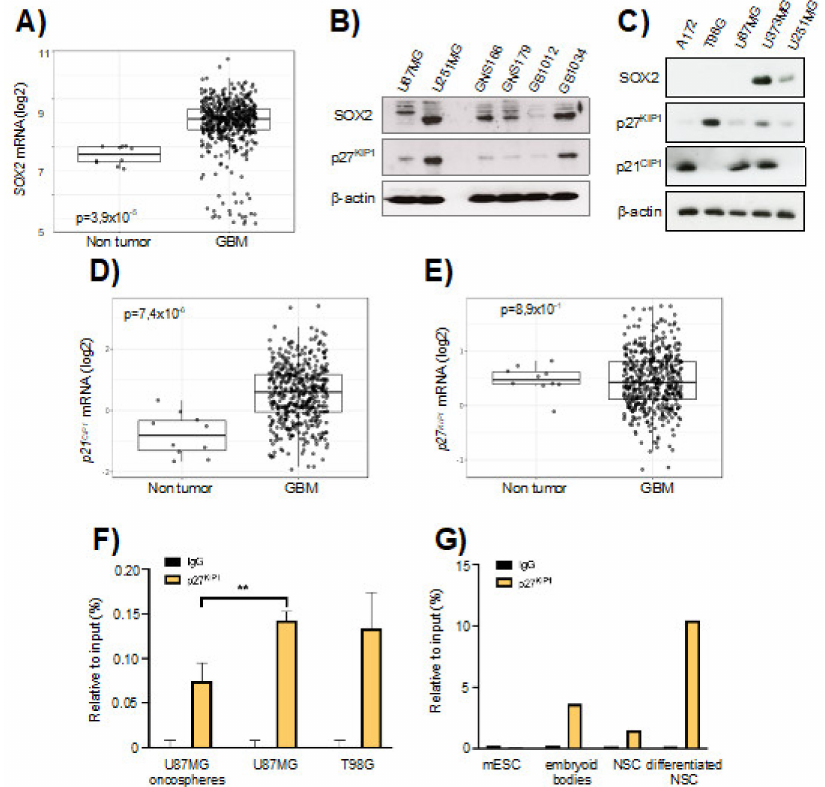
Figure 1. SOX2-SRR2 in glioma cells. ( A ) SOX2 mRNA expression in control ( n = 10) and GBM samples ( n = 528) from The Cancer Genome Atlas (TCGA) cohort in GlioVis database (http://gliovis.bioinfo.cnio.es (accessed on 22 January 2021)). ( B ) Immunoblotting of SOX2 and p27 KIP1 in U87MG and U251MG cell lines, in GNS166 and GNS179 patient- derived stem cell lines and in GB1012 and GB1034 GBM biopsies, β -actin was used as loading control. ( C ) Immunoblotting of SOX2, p27 KIP1 and p21 CIP1 in A172, T98G, U87MG, U373MG and U251MG cells, β -actin was used as loading control. ( D ) p21 CIP1 and ( E ) p27 KIP1 mRNA expression in control ( n = 10) and glioblastoma (GBM) samples ( n = 528) from The Cancer Genome Atlas (TCGA) cohort in GlioVis database. ( F ) Chromatin immunoprecipitation (ChIP) of p27 KIP1 at SOX2-SRR2 of two different stages: U87MG oncospheres vs . U87MG parental cells and T98G parental cells ( n = 3). The statistical significance was assessed by ANOVA test: * p < 0.05, ** p < 0.01 and *** p < 0.001. ( G ) ChIP of p27 KIP1 in the SOX2-SRR2 of mouse embryonic stem cells (mESCs) and neurospheres (neural stem cells, NSCs) before and after differentiation ( n =